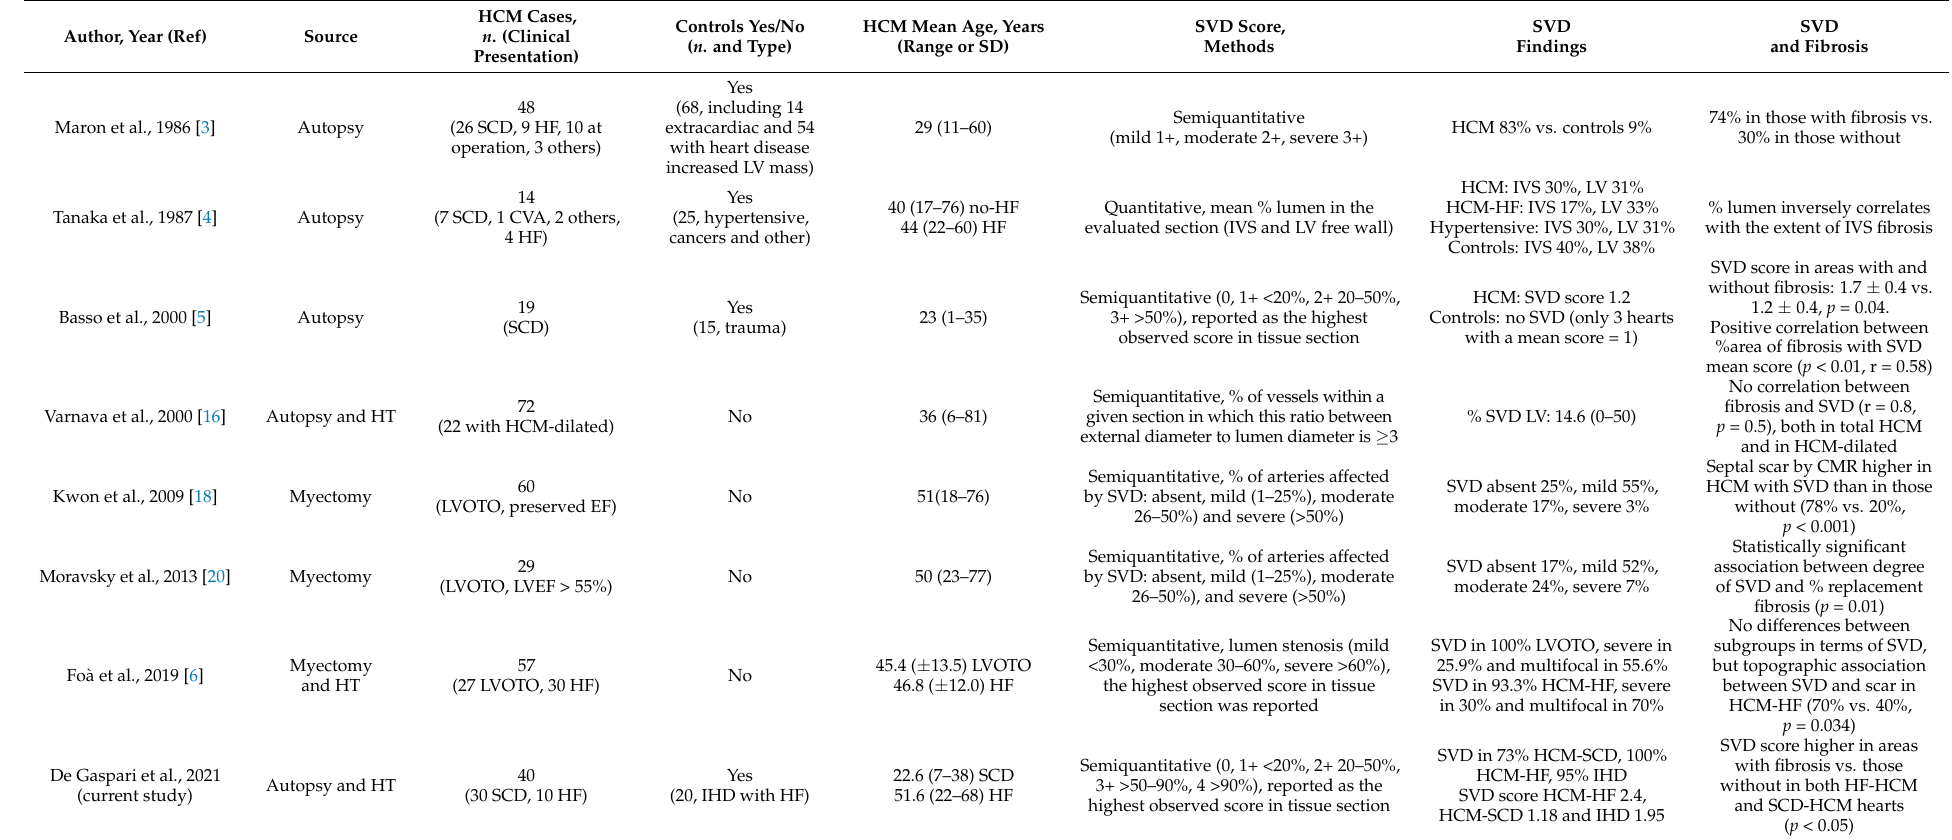
Table 2. SVD and relationship with fibrosis in HCM: literature